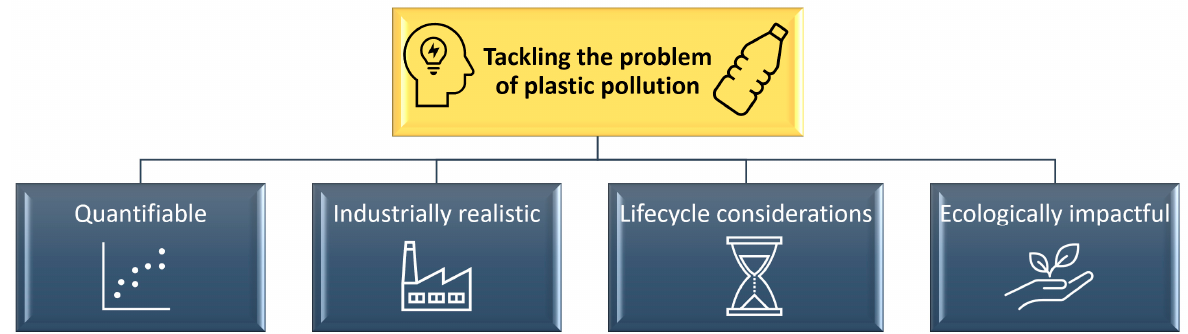
Figure 1. Overlooked aspects that need to be considered when tackling the problem of nanoplastic pollution, a key environmental global concern.